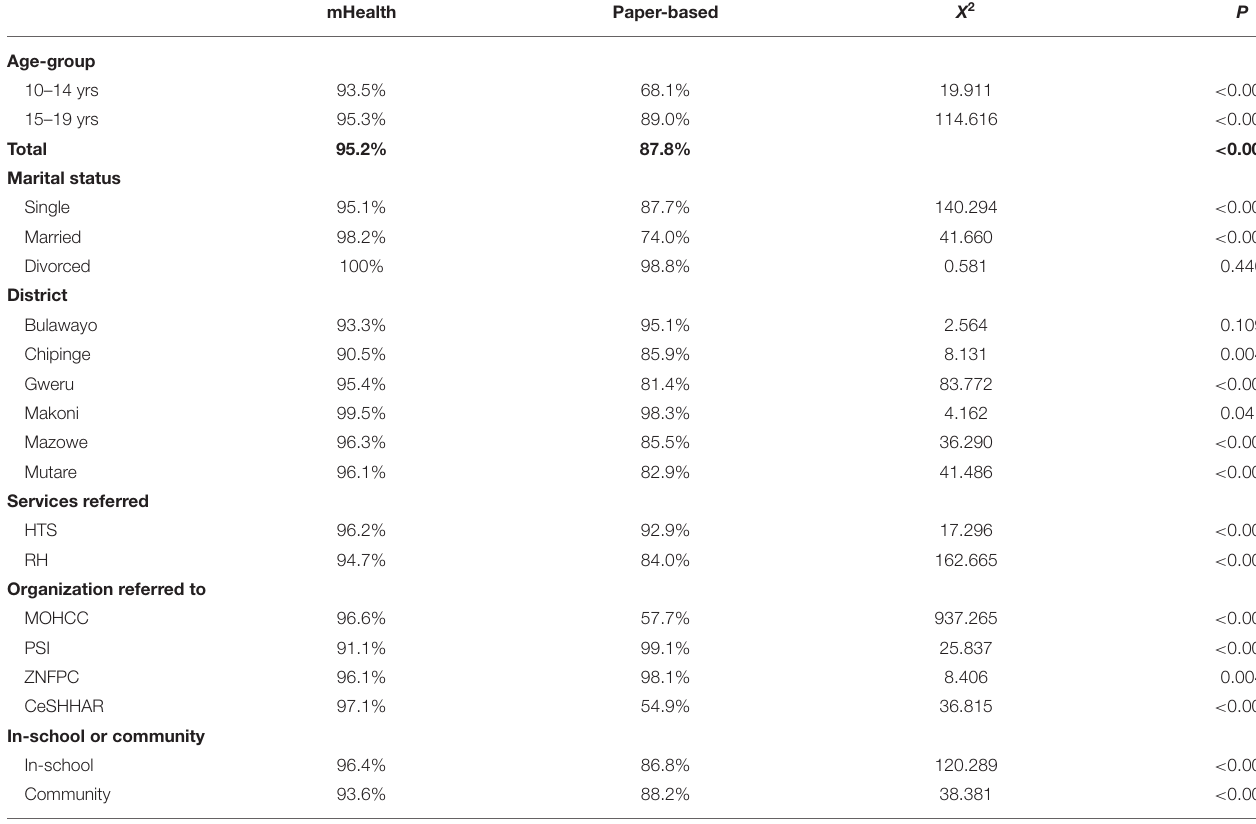
TABLE 2 | Differences in referral completion between mhealth and the paper-based system.